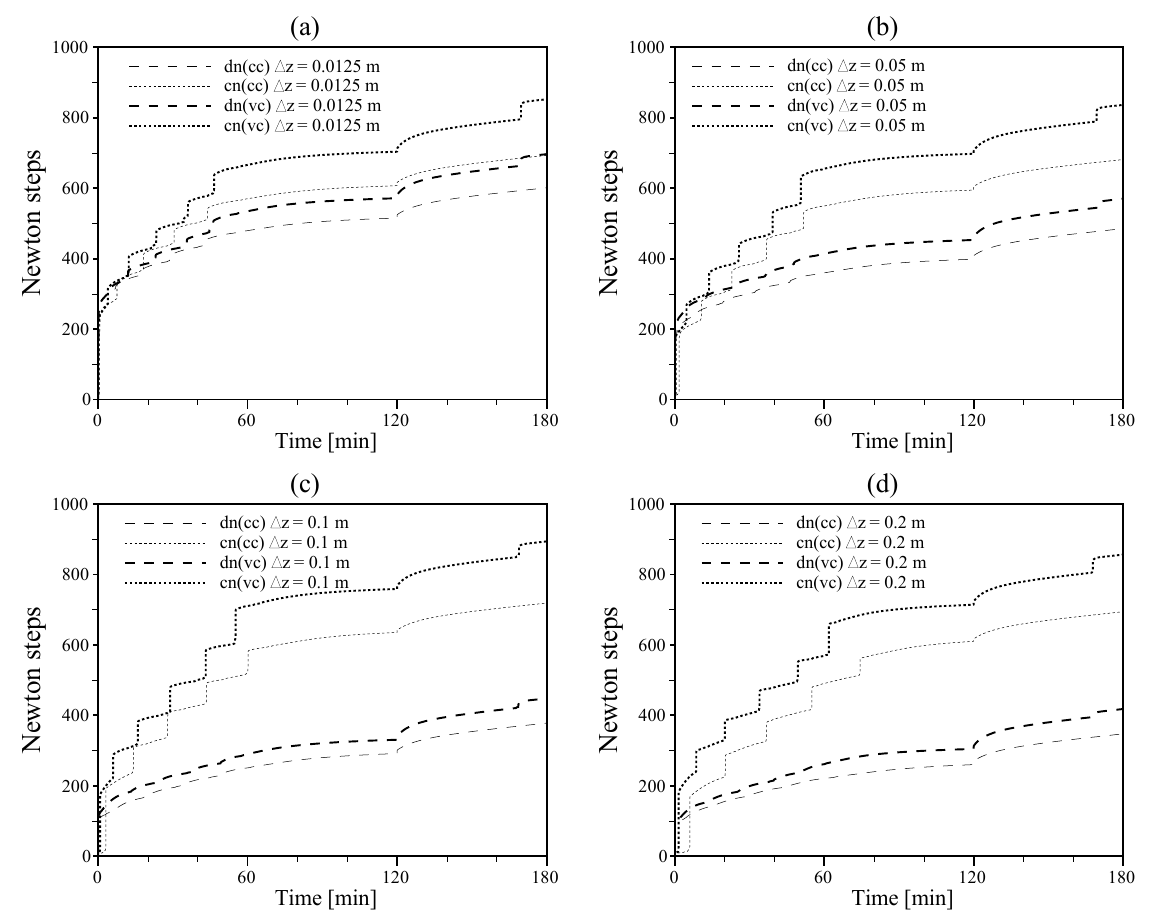
Figure 11. Number of Newton steps for flooding an unsaturated hillslope using different vertical discretizations.